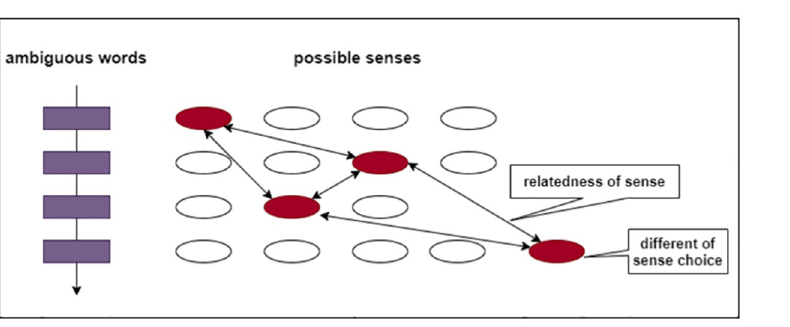
Fig 22. Graphical representation of Lesk.